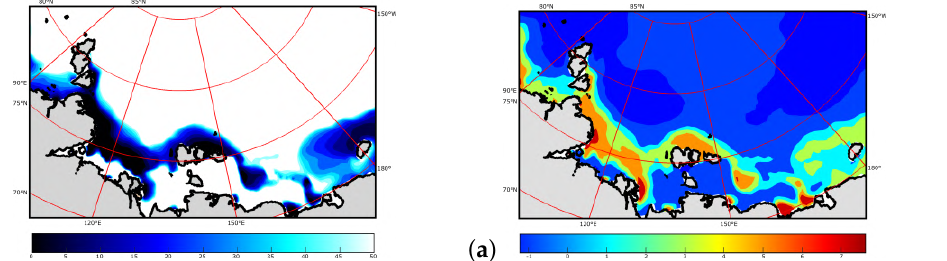
Figure 14. Simulated monthly average ( a ) ice concentration (%), ( b ) and sea surface temperature ( ◦ C) in July 2020 in control experiment